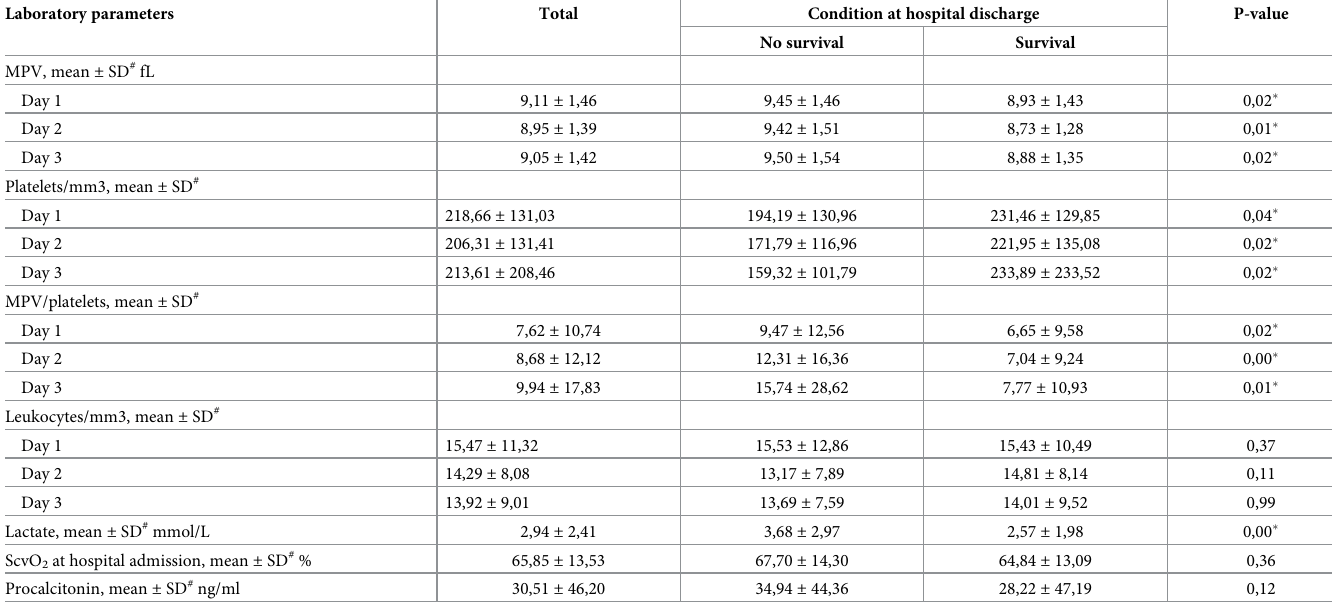
Table 3. Comparison of laboratory parameters of patients with sepsis based on the condition of hospitalization discharge in survival or no survival. Laboratory